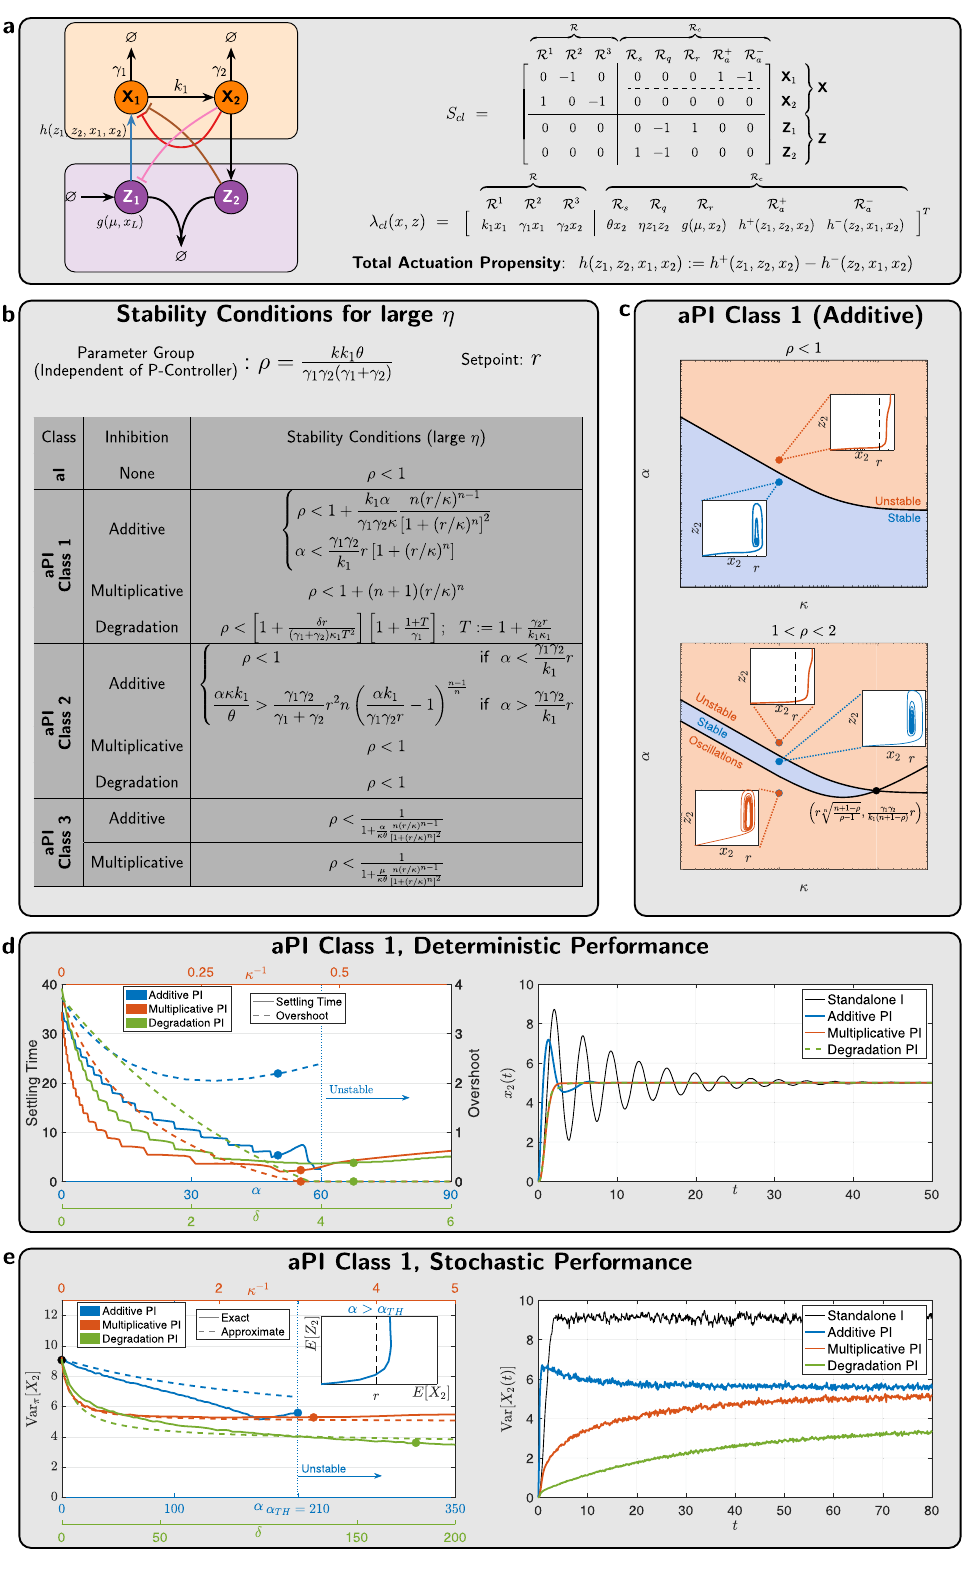
controller realizes an “ antithetic differentiator ” , whereby the antithetic motif feeds back into itself: Z 3 feeds back into Z 4 via the rate function g ( z 3 , x L ). In fact, this idea is inspired by a mathematical trick in control theory (see Supplementary Informa- tion Section 7) that basically exploits an integral controller, in